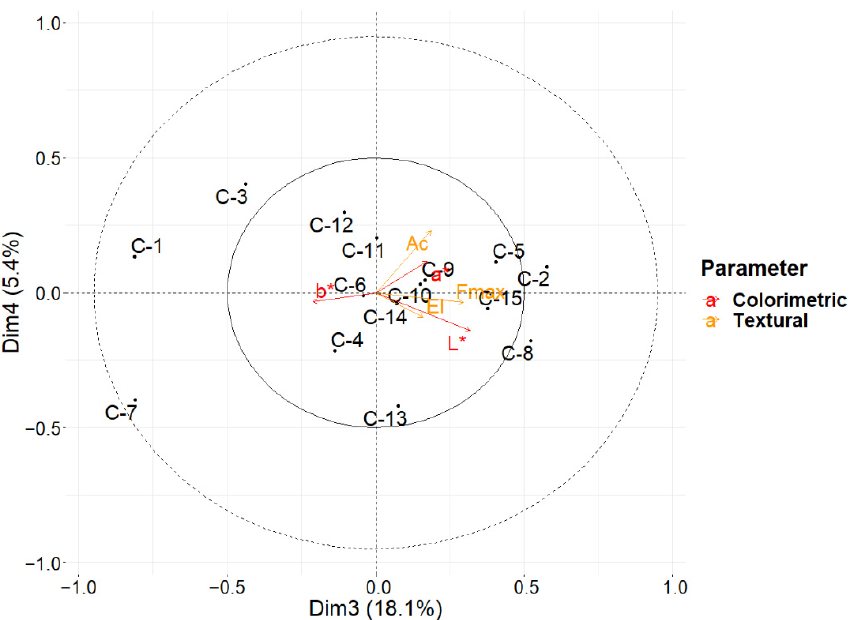
Figure 6. Biplot for ASCA showing the values for the third and fourth principal components for the LMM-ASCA decomposition to the factor “Dairy Factory”. Score values for each level are represented by black dots and labeled from C-1 to C-15 for each dairy factory. Loading values are represented using arrows for each parameter acquired, and colored according to the type of the measurement: “El” stands for elastic modulus; “Ac” for the area under the curve; “Fmax” for maximum force; “L*”, “a*”, and “b*” labels are referred to the coordinates of the lab color spaces.